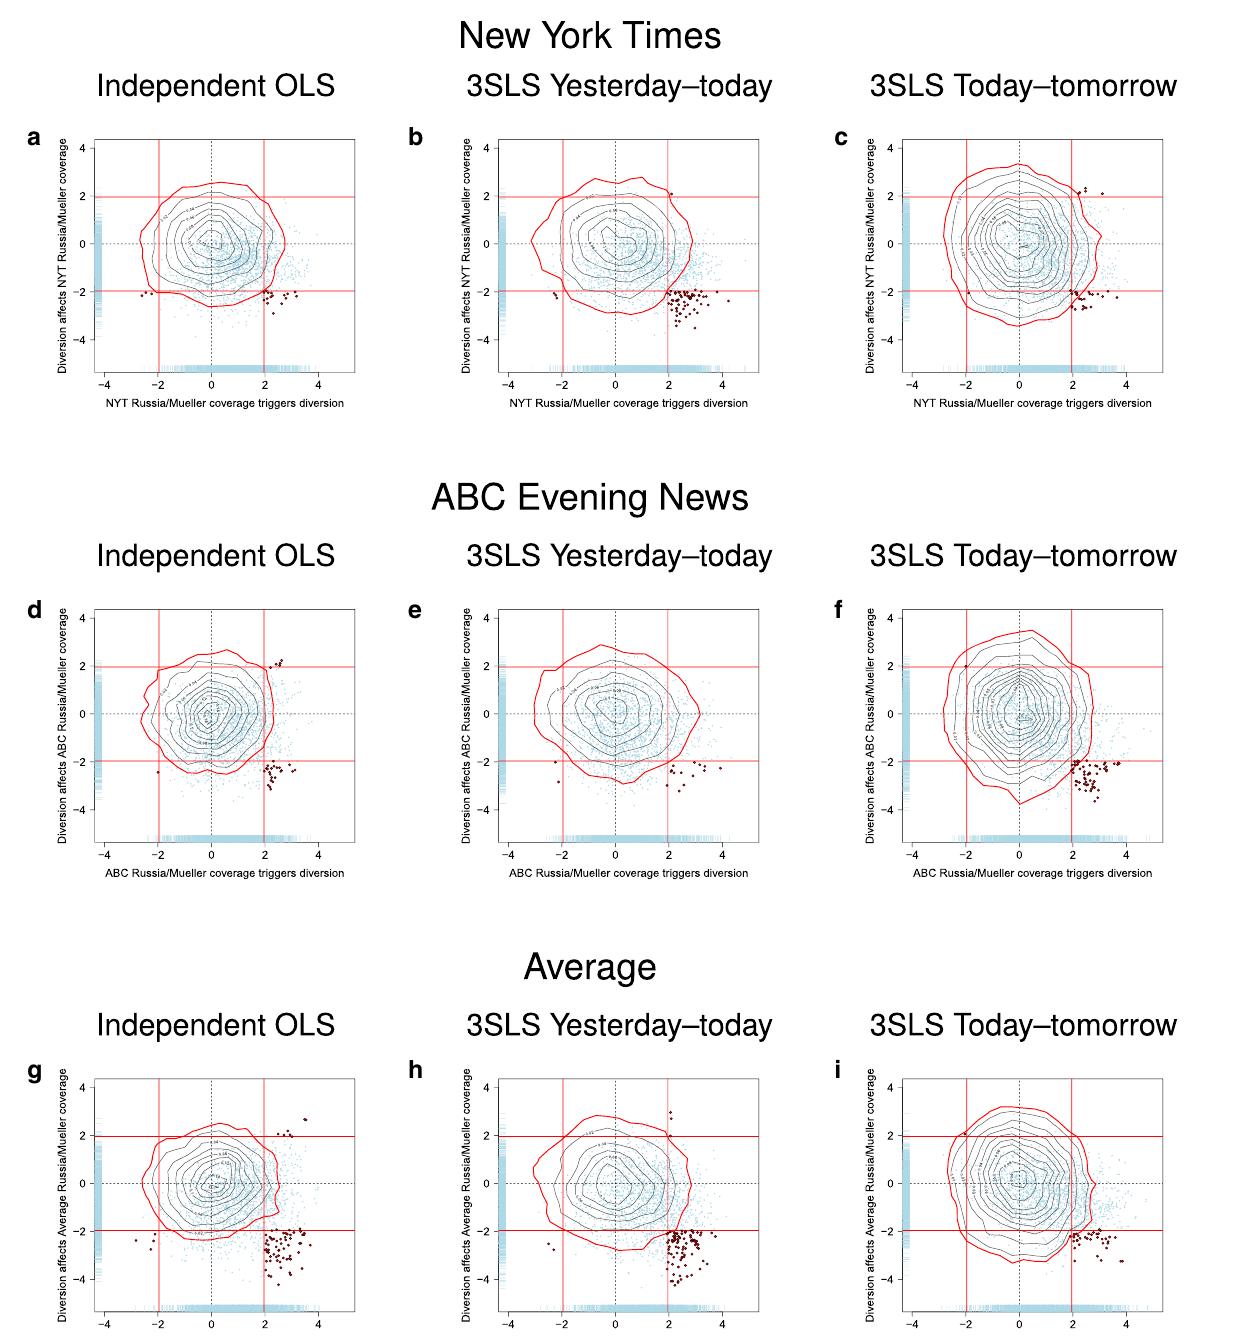
Fig. 4 Association between Russia-Mueller coverage in the media and diversion, and association between diversion and subsequent Russia-Mueller coverage. The top row of panels shows the results for the NYT (panels ( a – c )). The center ( d – f ) and bottom ( g – i ) row of panels show results for ABC News and the average of both media outlets, respectively. The left column of panels ( a , d , g ) shows results from two independent OLS models, the center column ( b , e , h ) is for a single 3SLS model in which suppression is modeled by relating yesterday ’ s tweets to today ’ s coverage, and the right column ( c , f , i ) is a 3SLS model in which suppression is modeled by relating today ’ s tweets to tomorrow ’ s coverage. In each panel, the axes show jittered t -values of the regression coef fi cients for diversion (X-axis) and suppression (Y-axis). Each point represents diversion and suppression for one pair of words in the Twitter vocabulary. Red vertical and horizontal lines denote signi fi cance thresholds (±1.96). Word pairs that are triggered by Mueller coverage ( p < 0.05) and affect subsequent coverage ( p < 0.05) are plotted in red. The gray contour lines in each panel show the distribution of points obtained if the timeline of tweets is randomized (red perimeter represents 95% cutoff, see “ Methods ” ). The blue rugs represent univariate